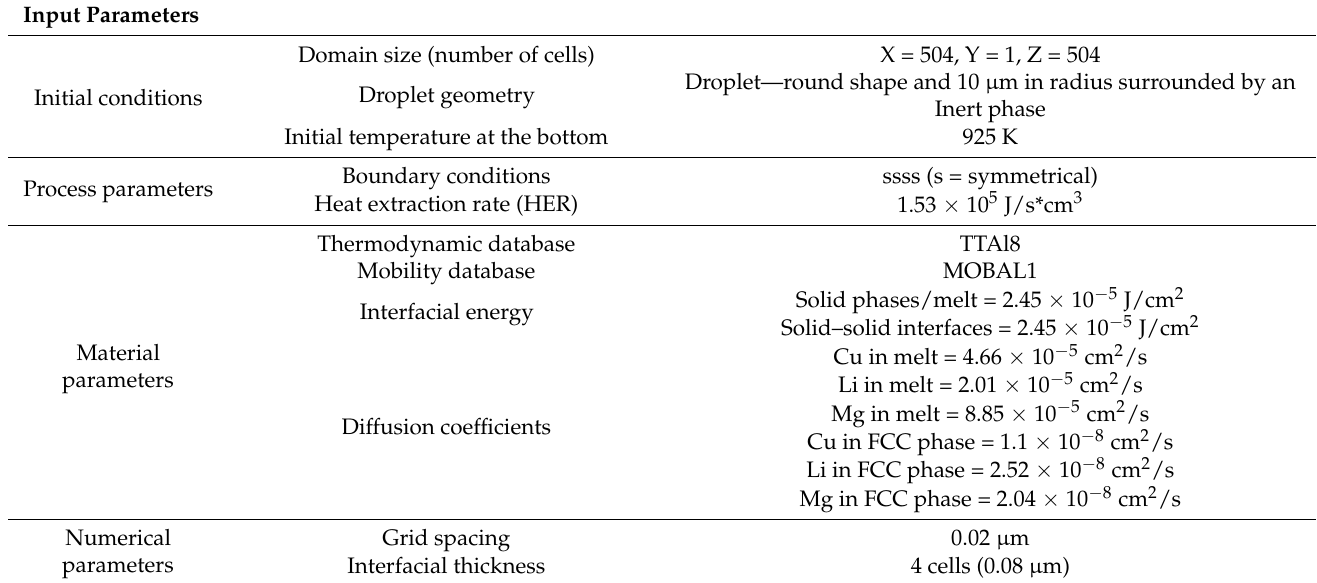
Table 2. Input parameters for the phase-field simulation.